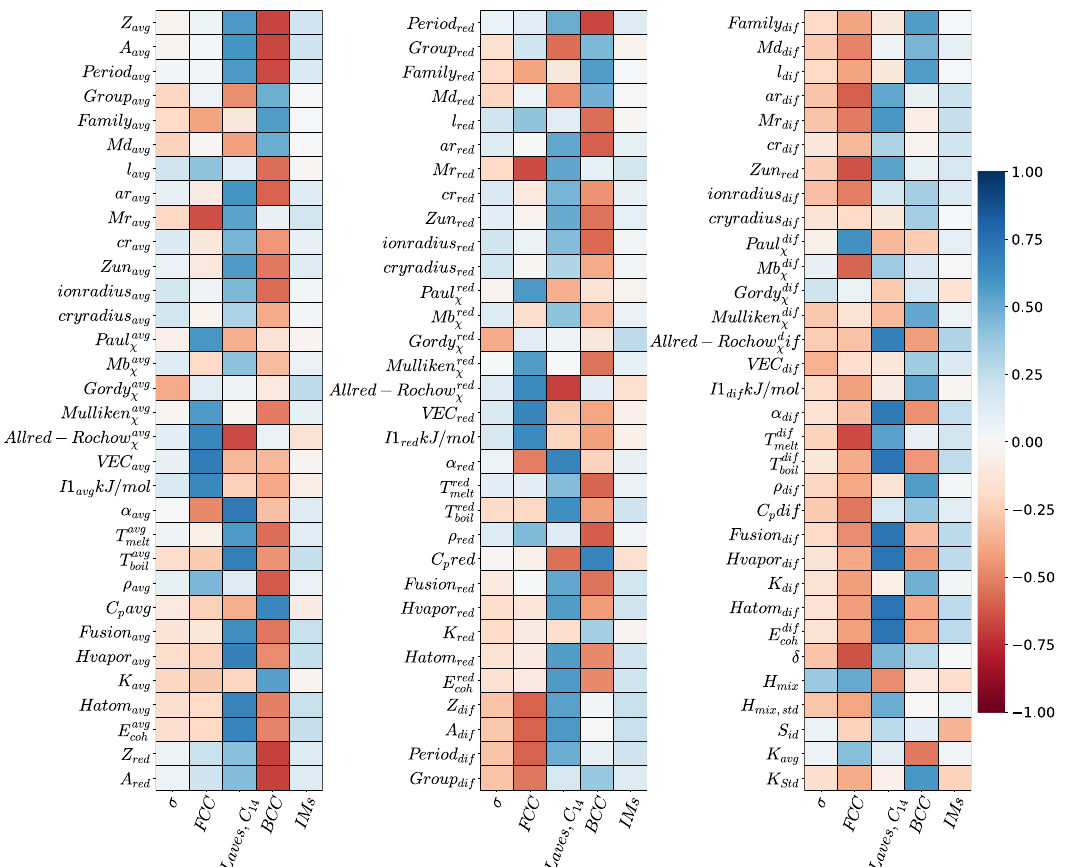
Fig. 1 Pearson ’ s correlations of feature space. Pearson ’ s correlation between the constructed feature space and the fi nal fi ve